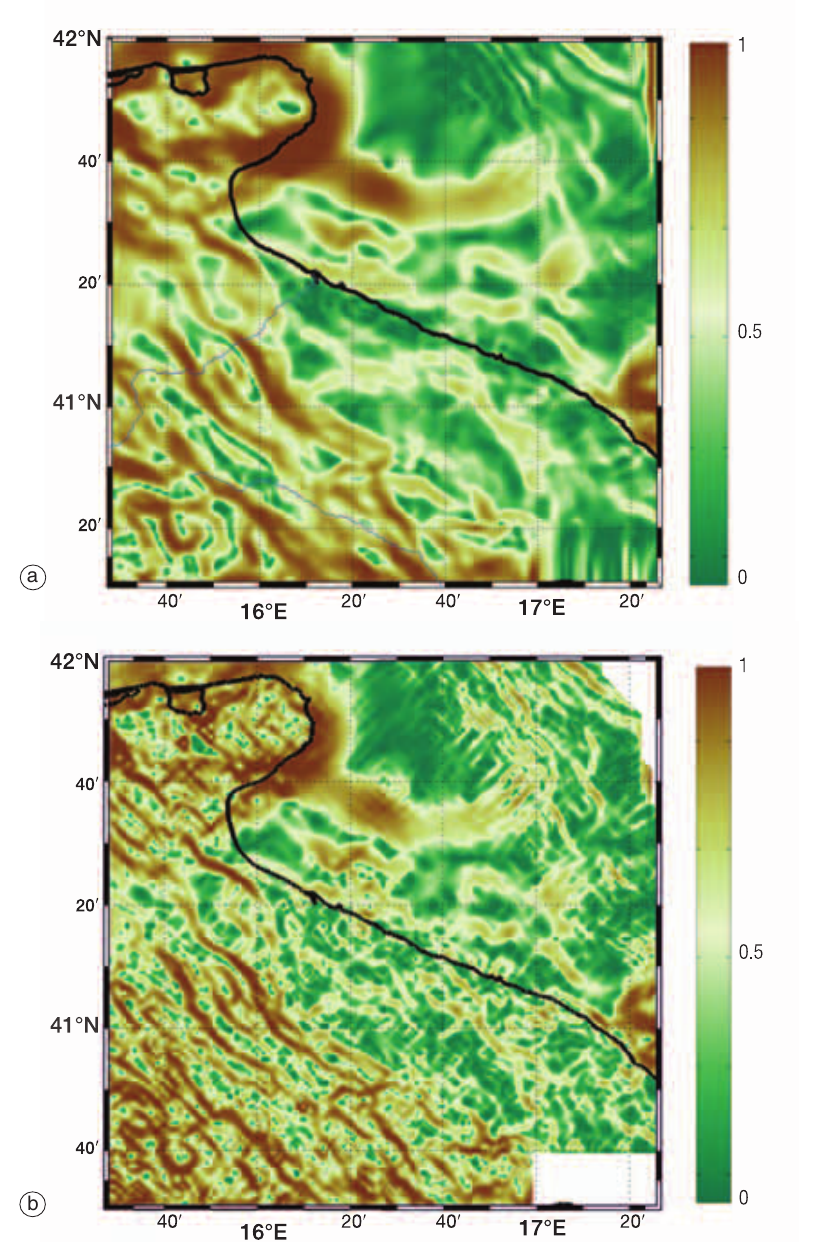
Fig. 4a,b. a) Intermediate scale MDA map of Bouguer anomaly gravity field in the area windowed as shown in fig. 3. b) Short scale MDA map of Bouguer anomaly gravity field in the area windowed as shown in fig. 3. Lineaments are represented by trends of maxima, which are graphically recognised by the colorbar in normalized